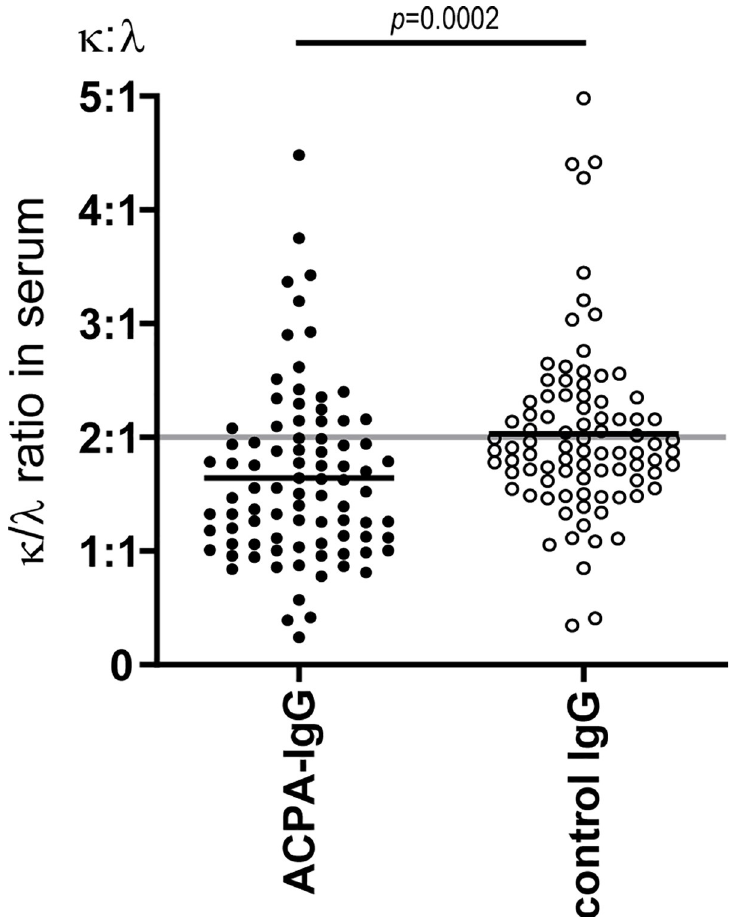
Fig 1. Frequency of lambda LC in ACPA-IgG and control IgG in serum of RA patients. κ / λ ratios in paired ACPA-IgG and control IgG in serum of RA patients (n = 87) where the grey line depicts the κ / λ ratio of 2:1 (67%-33%) in healthy individuals as reported in literature. Data were assessed as parametric paired samples in student’s t -test.